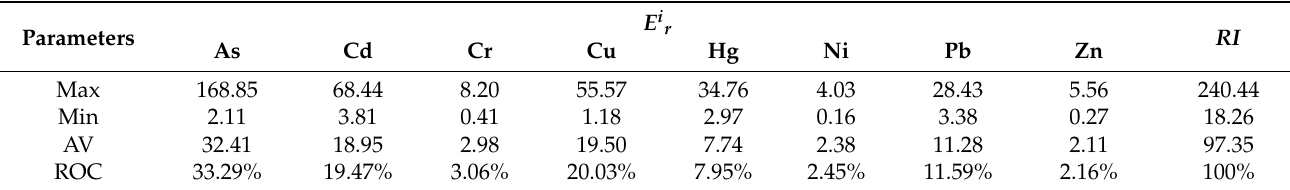
Table 8. PERI results of heavy metals in stream sediments of the Misiones